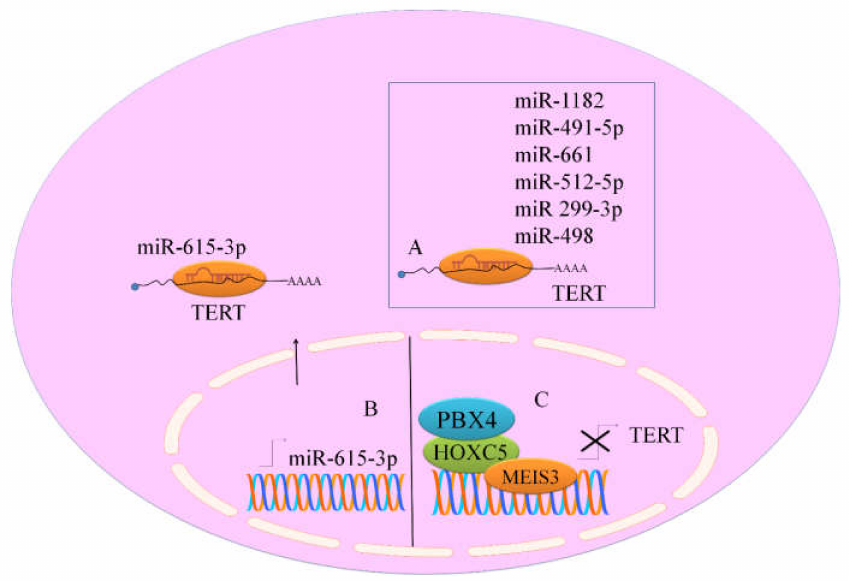
Figure 2. Regulation of telomerase by different miRNAs ( A ). miR-615-3p ( B ) is transcribed from HOXC5 ( C ). Both HOXC5 and miR-615-3p negatively regulated TERT. HOXC5 promoted loading of PBX4 and MEIS3 to repress TERT. HOXC5 , one of several homeobox HOXC genes located in a